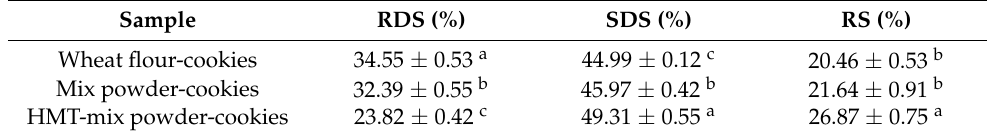
Table 8. Englyst digestion values of starch fractions of cookies made from wheat flour, mix powder and HMT-mix